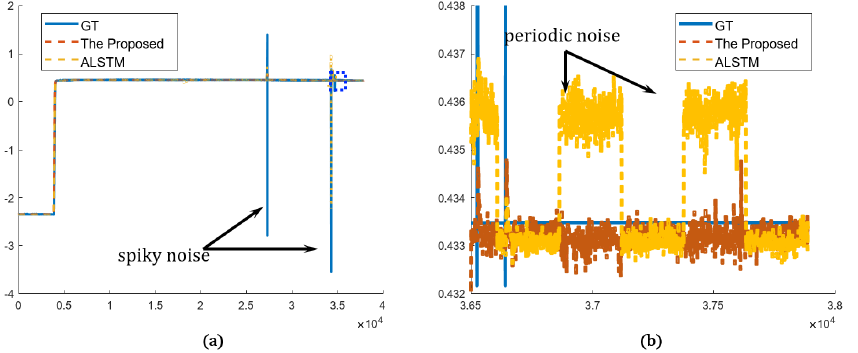
Figure 11. Prediction results in time domain (sensor A): ( a ) overview of the proposed and the best in other methods compared to the GT; ( b ) detailed view of the blue dotted rectangle of ( a ).